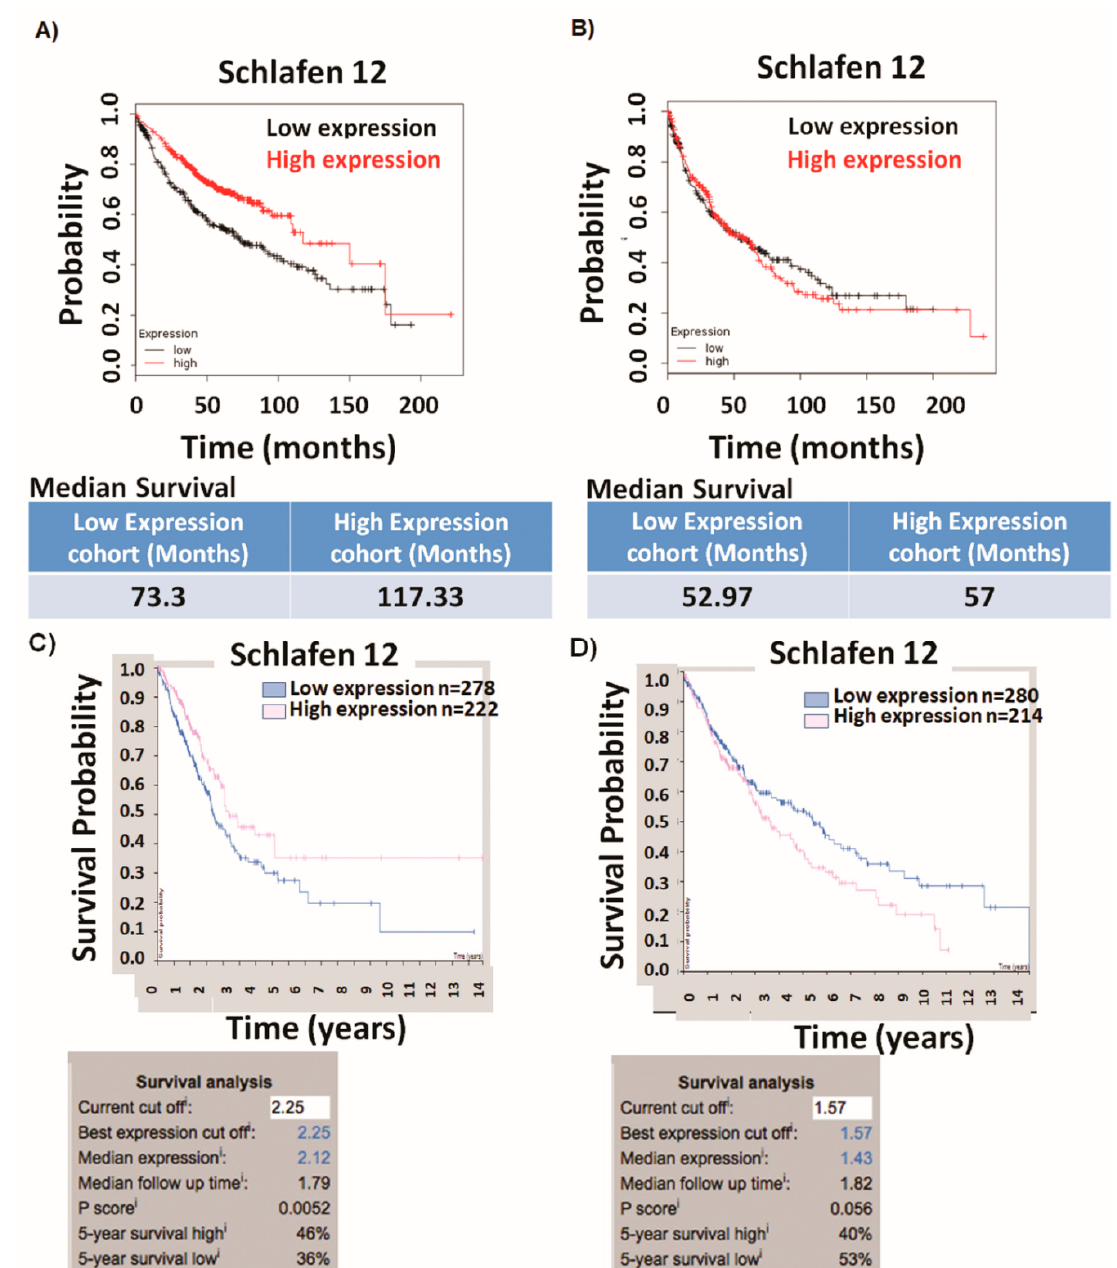
Figure 1. Schlafen12 (SLFN12) correlates with survival of lung adenocarcinoma. Survival analysis of publicly available dataset of cohorts of patients with lung cancer (http://kmplot.com/analysis/) shows that ( A ) SLFN12 expression correlates with overall survival after diagnosis in lung adenocarcinoma (LUAD) ( n = 719, p < 0.01) and ( B ) SLFN12 expression does not correlate with overall survival after diagnosis in patients with lung squamous cell carcinoma (LUSC) ( n = 524, p = 0.78). The median expression of SLFN12 was used as a cutoff value and median survival in months was calculated for both high and low expression cohort. Parallel survival analysis from a different tool (http://www.proteinatlas.org) confirms that ( C ) SLFN12 mRNA expression correlates with overall survival after diagnosis in LUAD ( n = 500, p = 0.0052), while ( D ) SLFN12 mRNA expression does not correlate with overall survival in patients with LUSC ( n = 494, p = 0.0056). fragments per kilobase of